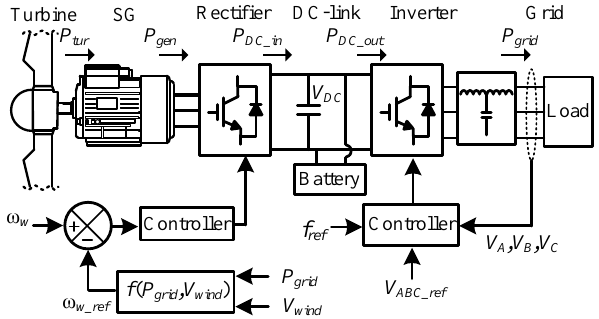
Figure 1. Autonomous wind unit operating in load-following mode with its typical control loops.